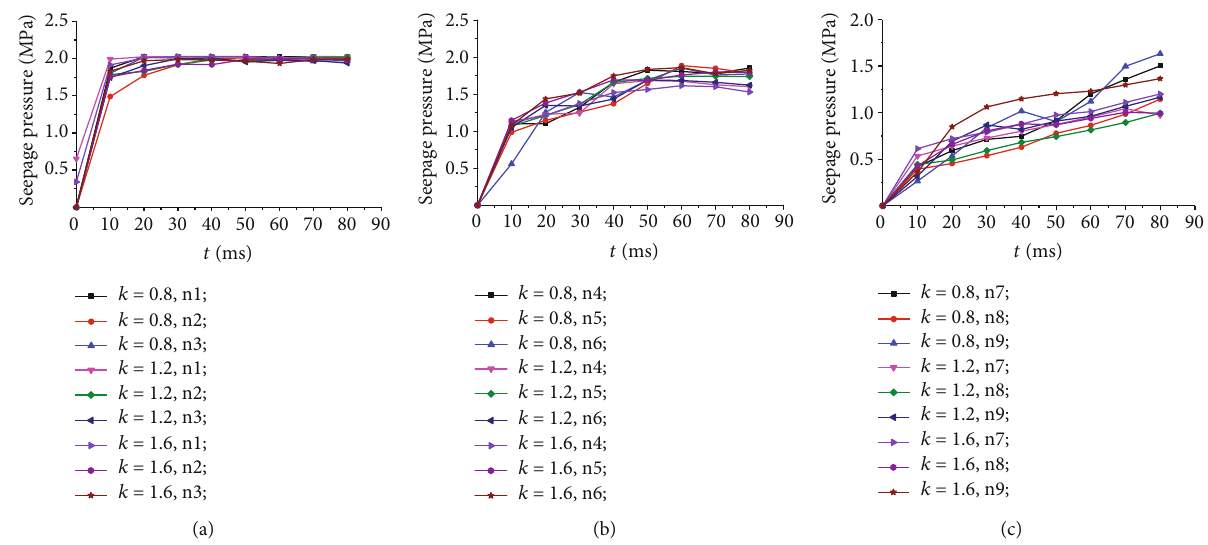
Figure 8: The trend of seepage pressure at the 9 measuring points in the conditions of k = 0 : 8 , 1.2, and 1.6: (a) n1 ~ n3 on HL1; (b) n4 ~ n6 on HL2; (c) n7 ~ n9 on